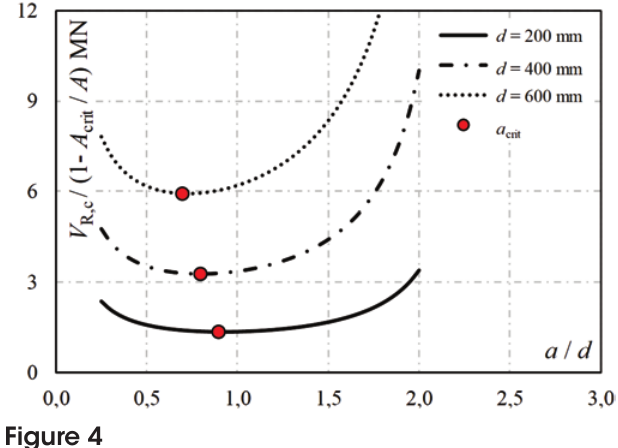
in function of the footing